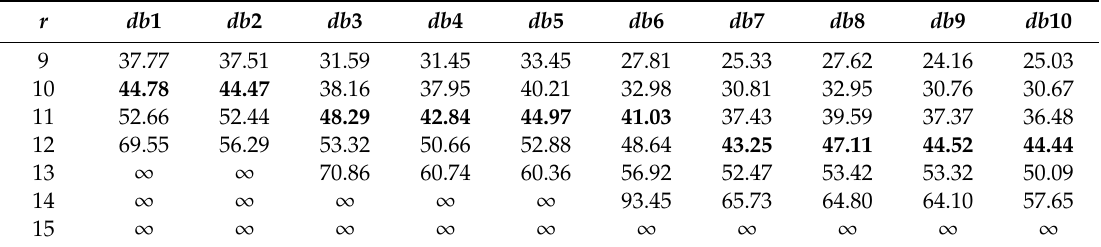
Table 13. Experimental results ( PSNR , dB) of 3D tomographic 8-bit image “wmri” DWT by using bit-width r of Daubechies wavelets filters coe ffi cients.